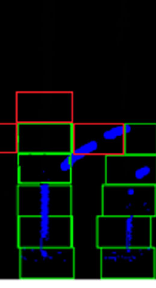
Figure 7. Exploratory windows for non-points regions found on sharp turning.